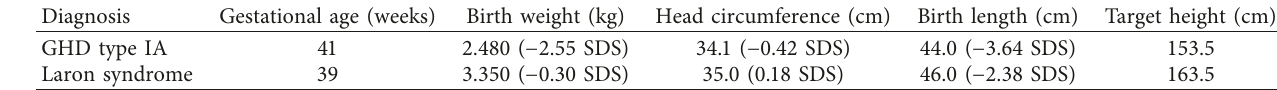
Table 1: Neonatal auxological parameters of the two patients.